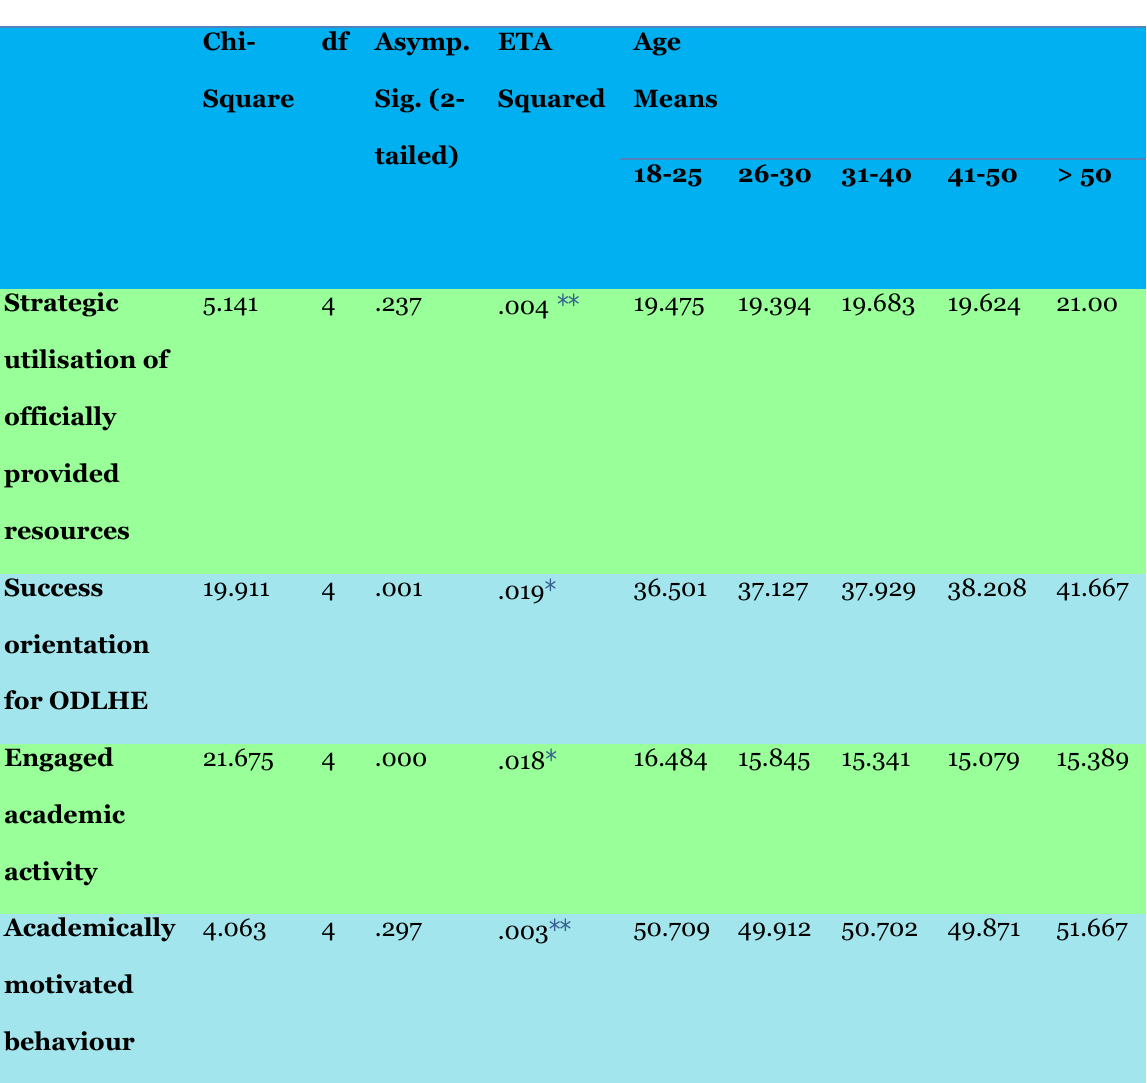
Table 3 below indicates how the various age groups differ with regard to the ALSDS constructs. Table 3 Results of the Kruskall-Wallace Test: